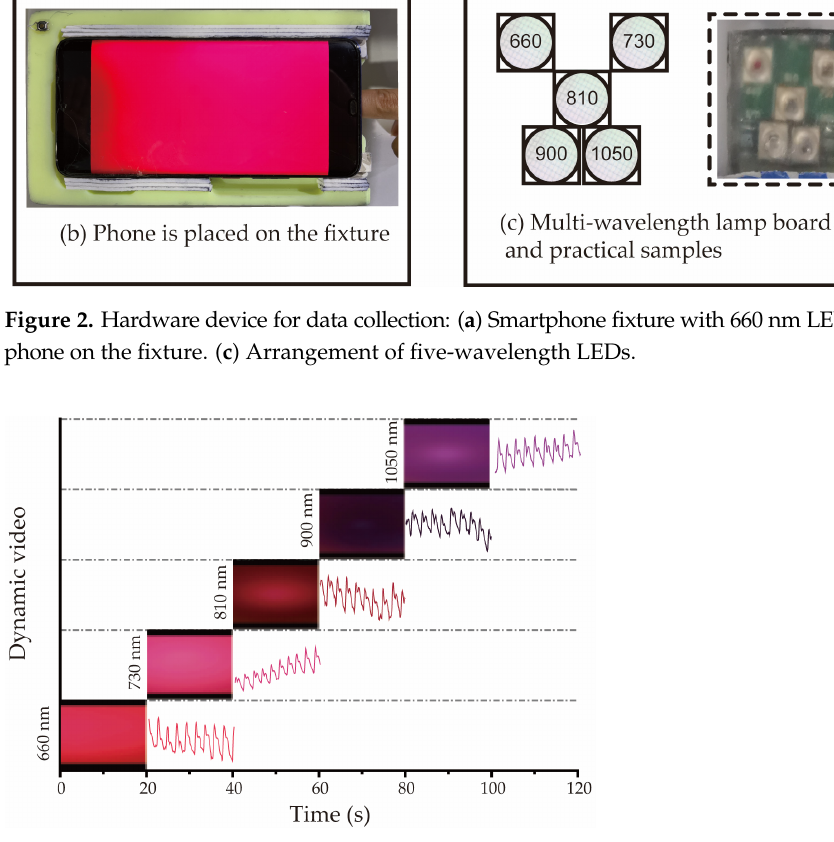
Figure 3. Schematic of the PPG data measurement and the waveforms display in sequence.